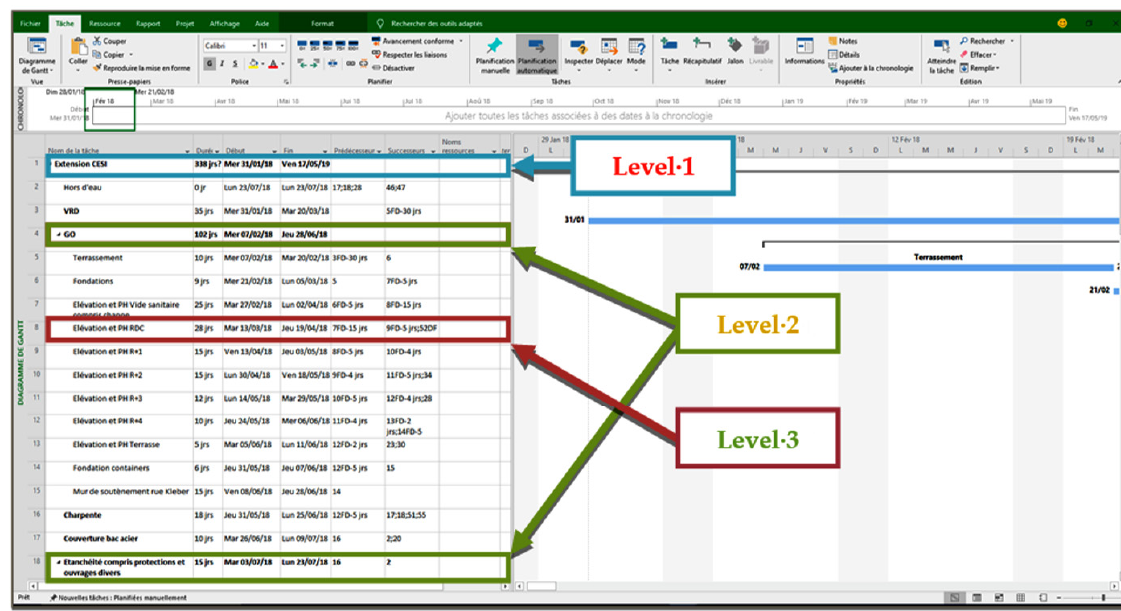
Figure 9. Screenshot of Nanterre 2 CESI project